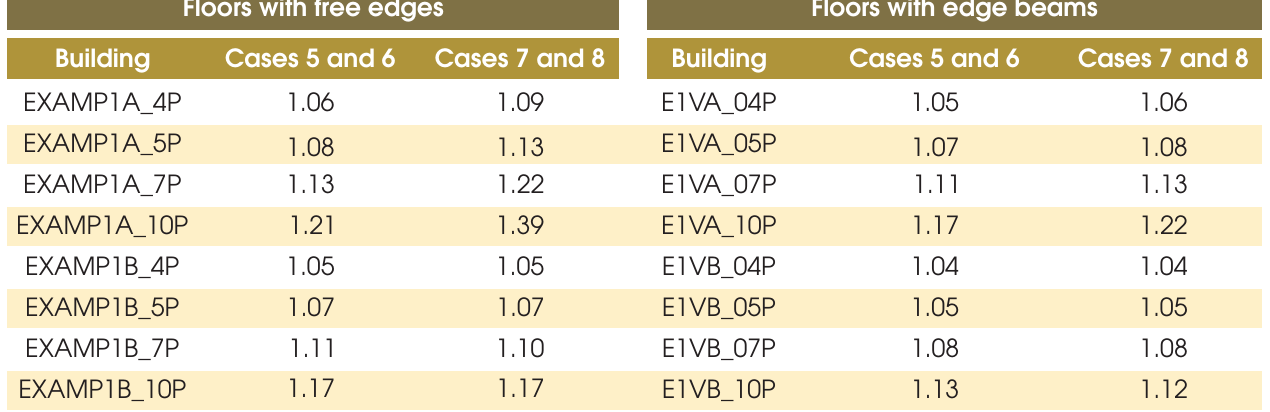
Table 7 – Values of the coefficients γ